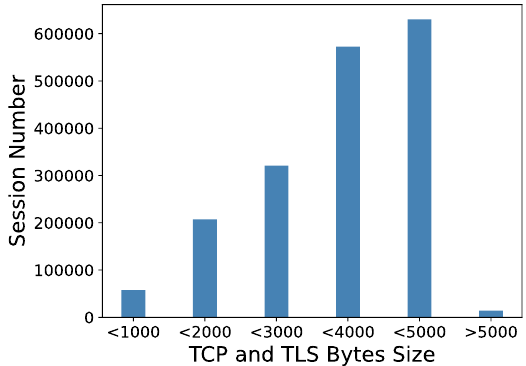
Figure 14. Distribution of TCP and TLS layer bytes.